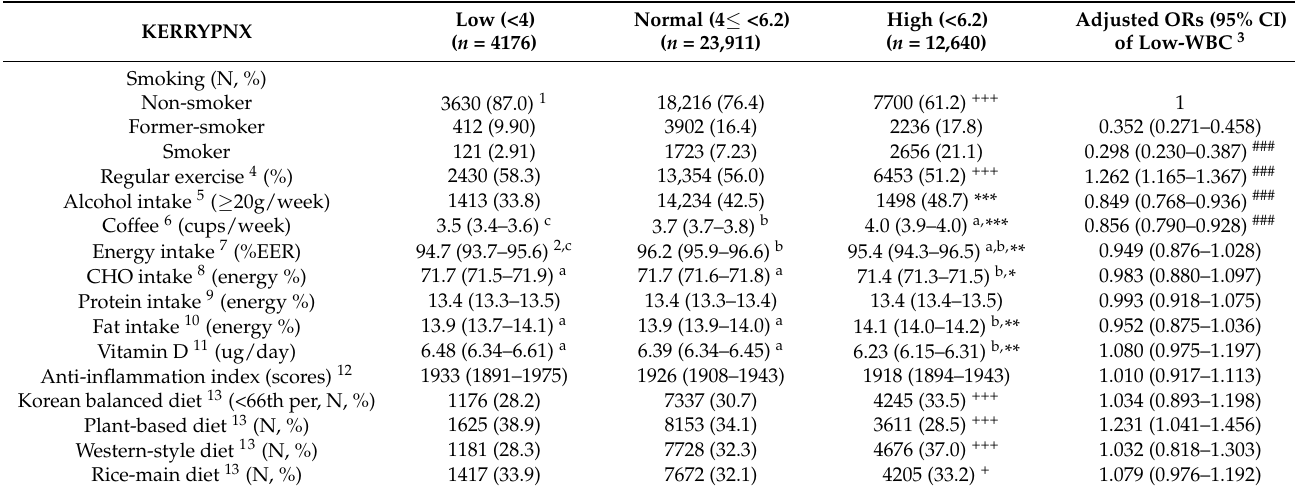
Table 2. Lifestyles and nutrient intake of the participants according to the contents of white blood cells (WBC) and adjusted odds ratio (ORs) of